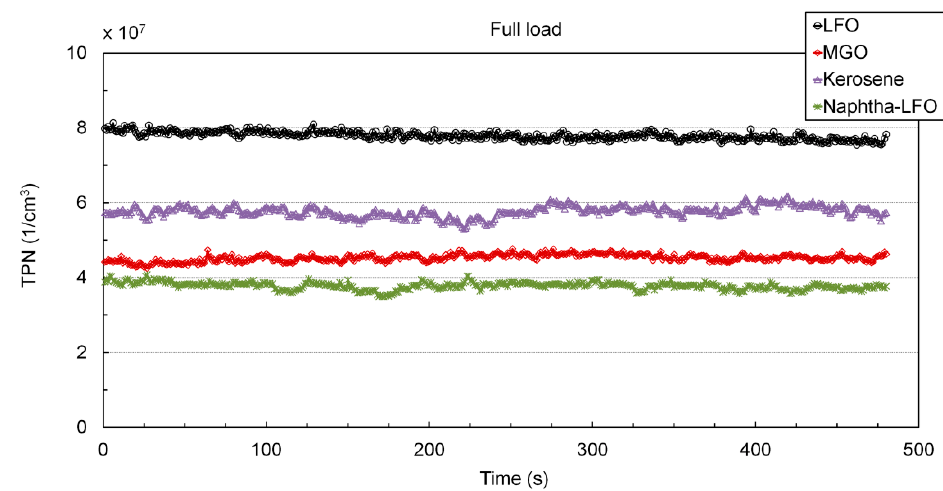
Figure 9. The actual TPN during eight-minute measurement time at full load.